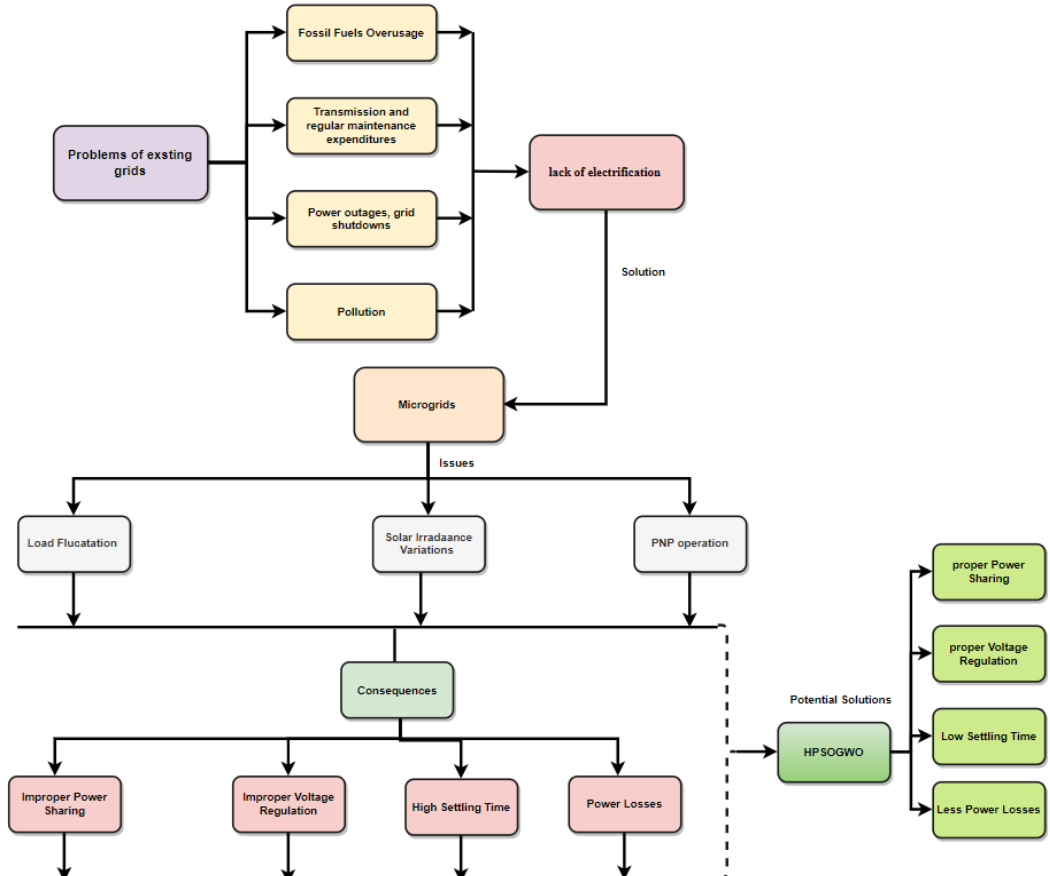
Figure 1. The main issues of the existing grids and microgrids.